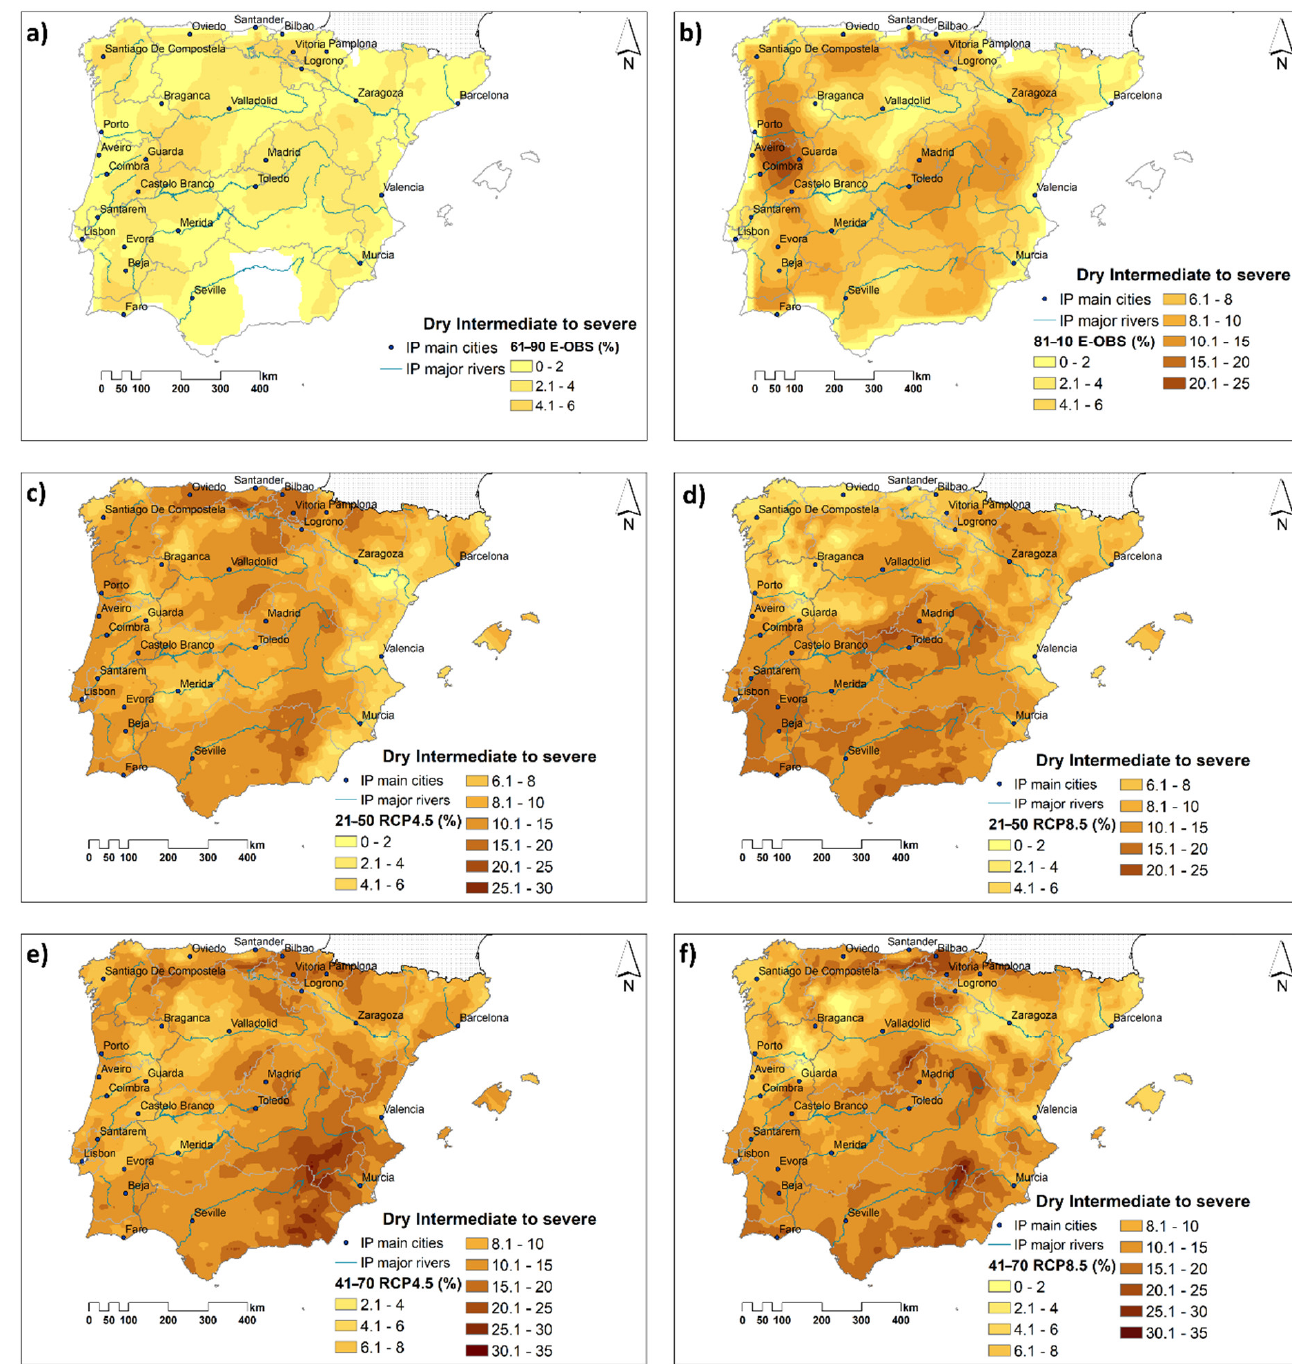
Figure 10. Probability (in %) of 12m-WASP intermediate-to-severe dry events in IP for the periods ( a ) 1961–1990, and ( b ) 1981–2010, ( c , d ) 2021–2050, ( e , f ) 2041–2070 under RCP4.5 (left) and RCP8.5 (right) (Note: NUTS 2 in grey contours).